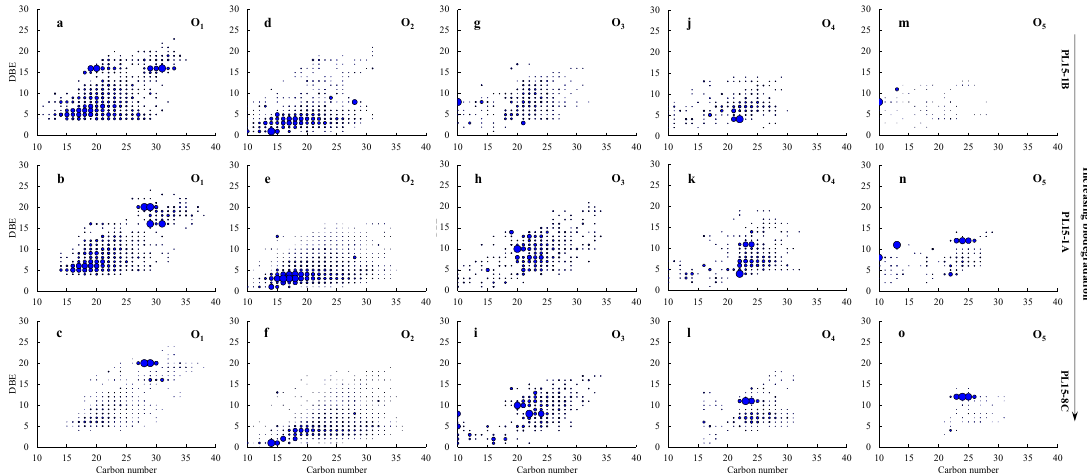
Figure 4. Iso-abundance plots of DBE versus carbon number of O 1 –O 5 classes in the crude oils. The size of circles represents the relative abundance of the species in the spectra. ( a – c ), ( d – f ), ( g – i ), ( j – l ), and ( m – o ) show the distribution of O 1 –O 5 classes for the PL15-1B, PL15-1A, and PL15-8C oils, respectively.